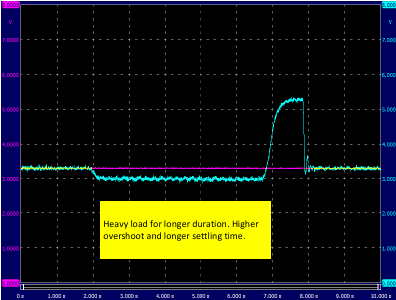
Heavy load for longer duration. Higher overshoot and longer settling